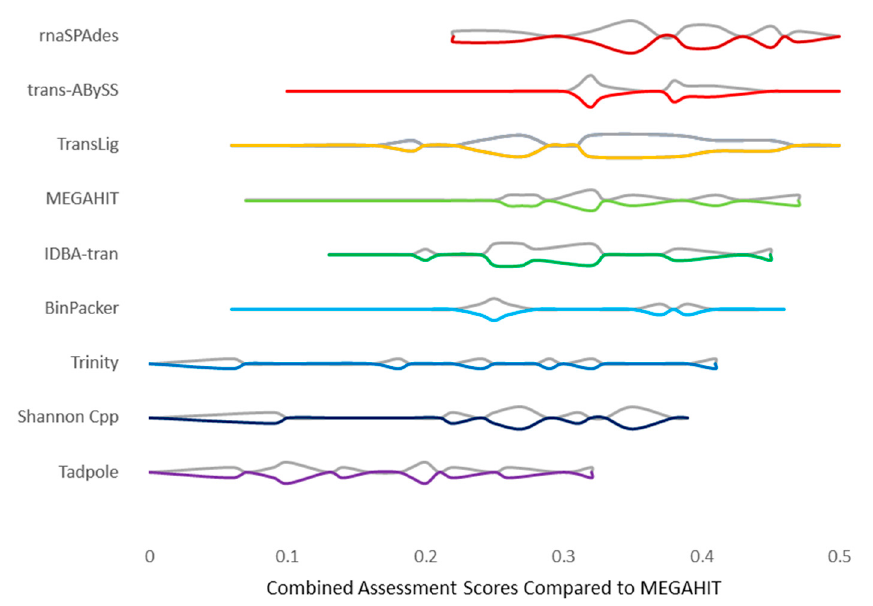
Figure 6. Tri-assembly score distributions. Violin plots representing assessment score fre-